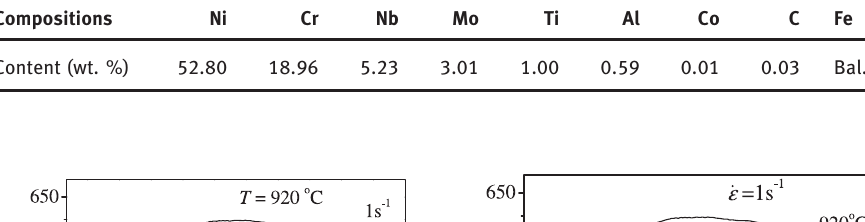
Table 1: The chemical composition of the studied Inconel 718 superalloy (wt. %). Compositions